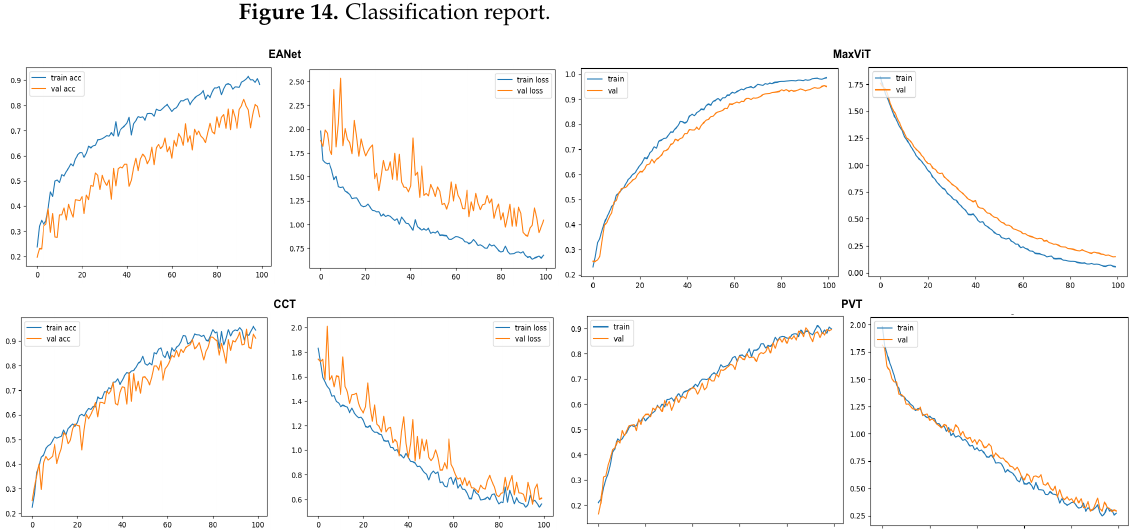
Figure 15. Accuracy and loss curves for the